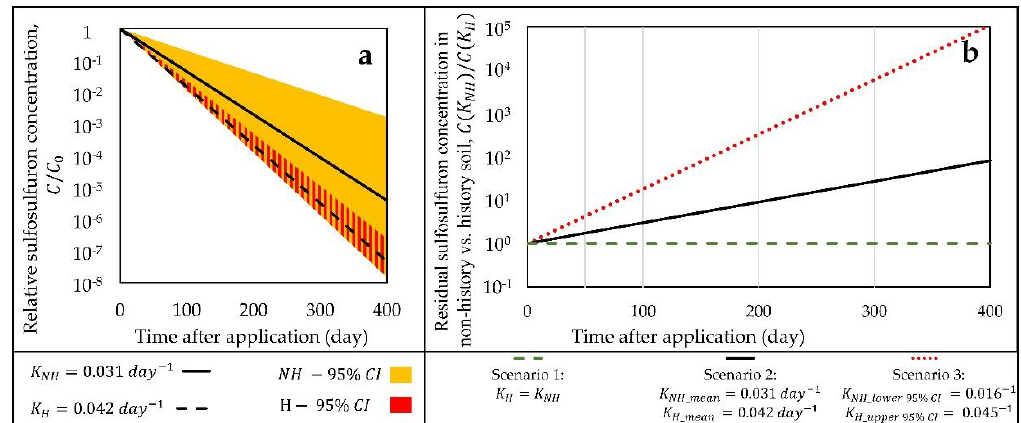
Figure 3. Dissipation of sulfosulfuron in soils considering different first-order degradation rate constant ( 𝐾 ) ( a ) and the resultant variation in residual sulfosulfuron concentrations in soil ( b ). Concentration after application was calculated using Equation (4) substituting 𝐾 with estimated values in the field experiment, ± 95% confidence interval (CI) (Table S4).